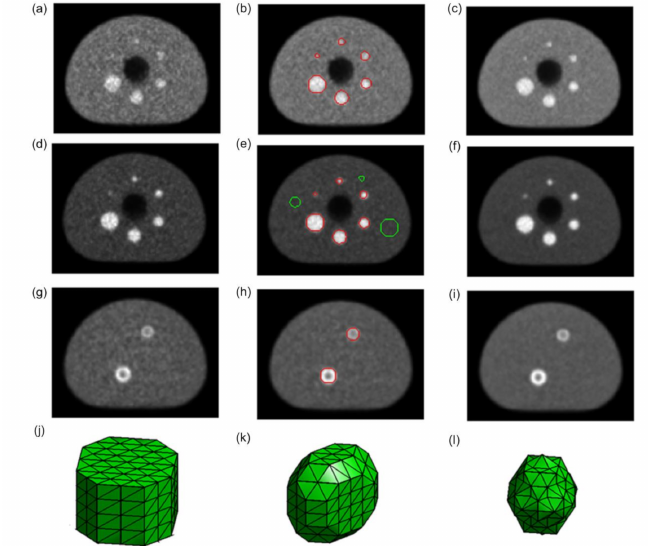
Figure 2. One reconstructed slice of the NEMA PET phantom with homogeneous spheres for contrast 2:1 ( a – c ) and 4:1 ( d – f ). The heterogeneous spherical inserts with cold inner core ( g – i ). ( a , d , g ) For 900 s reconstructions; ( b , e , h ) for 2000 s reconstructions; and ( c , f , i ) for 7200 s reconstructions. Red circles represent VOI ture and green circles represent spherical background VOIs with different